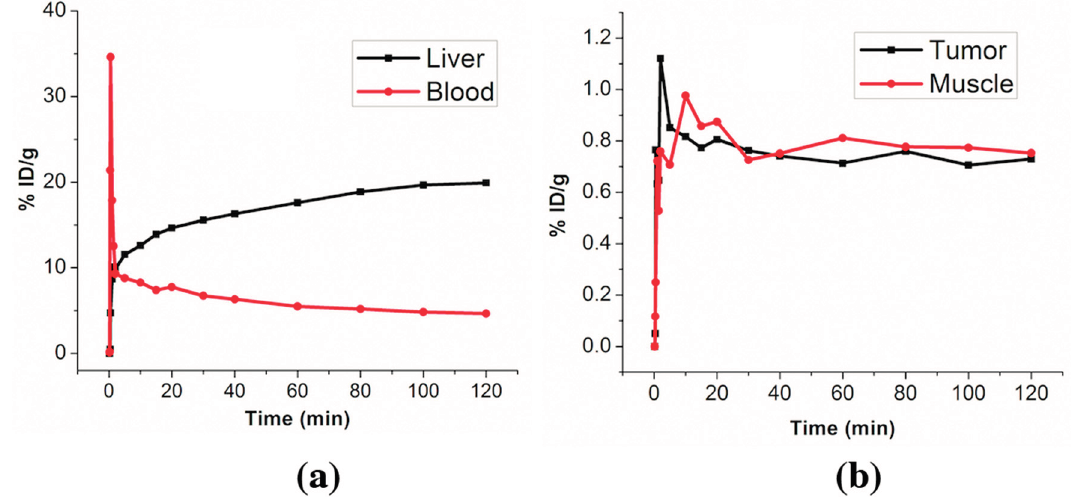
Figure 5. Plot of measured in vivo radioactivity versus time in liver, blood ( a ) and tumor, muscle ( b ) after tail vein injection of 100 μ L radiolabeled nanoprobes in PBS solution. The radioactivity was measured on acquired PET/CT scan